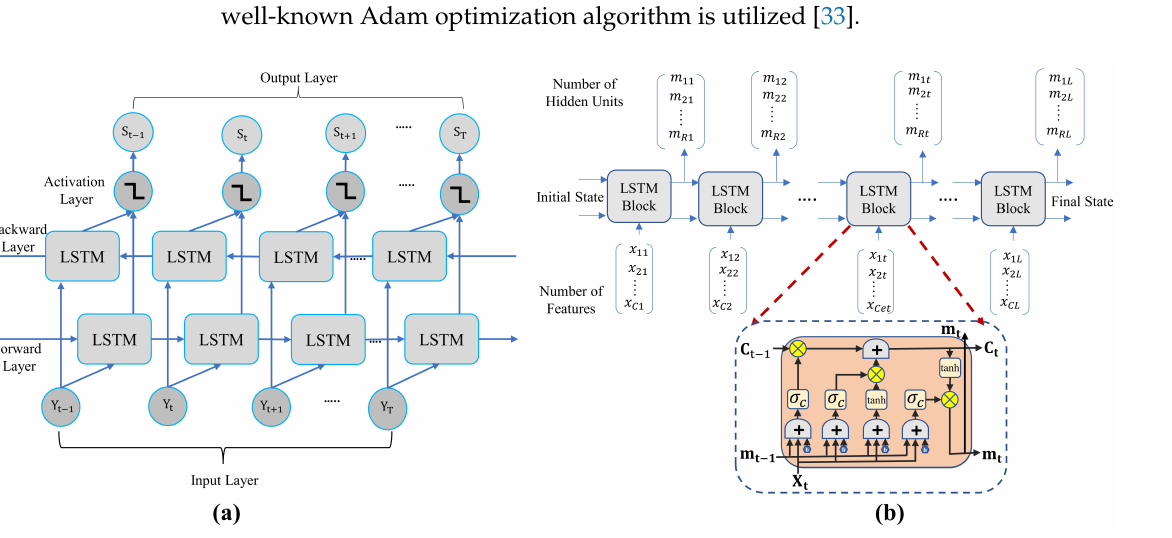
Figure 3. ( a ) The architecture of the Bi-LSTM model system with its different layers. ( b ) The internal cell structure of the LSTM